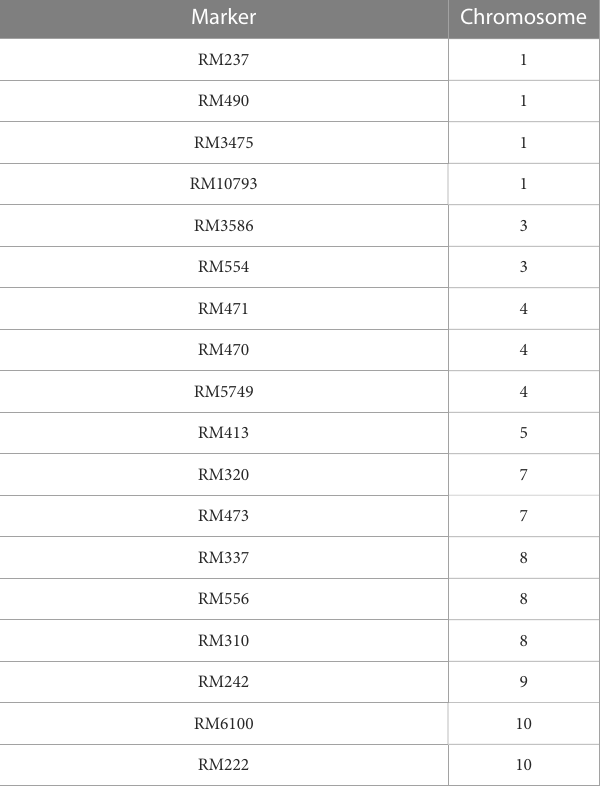
TABLE 4 List of SSR markers exhibiting polymorphism between parents.